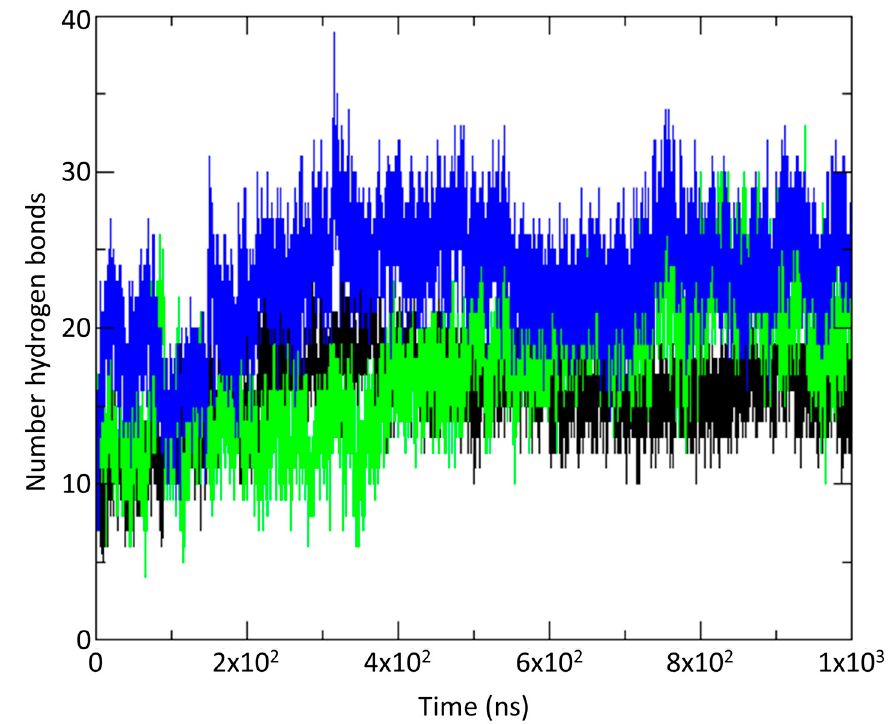
Figure 5. Number of interstrand (vCCI:chemokine) hydrogen bonds observed throughout the molecular dynamics (MD) trajectory for vCCI:vMIP-II (blue); vCCI:MIP-1 β (green) and vCCI:MIP-1 β -K45A/R46A/L48A (black).